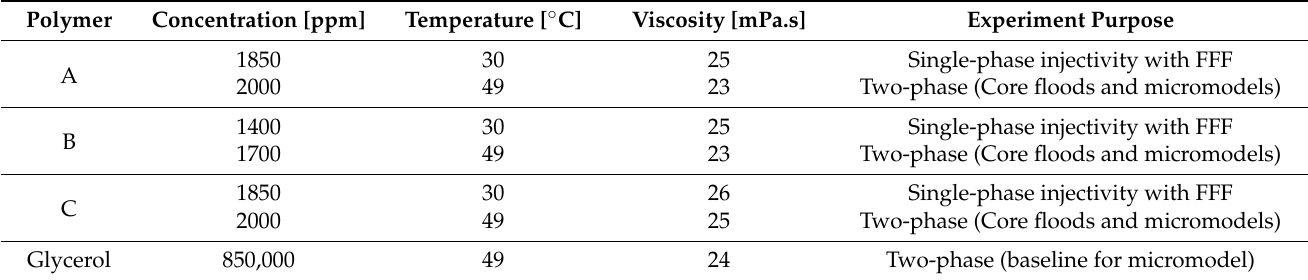
Table 2. Summary of polymer concentrations and parameters of polymer